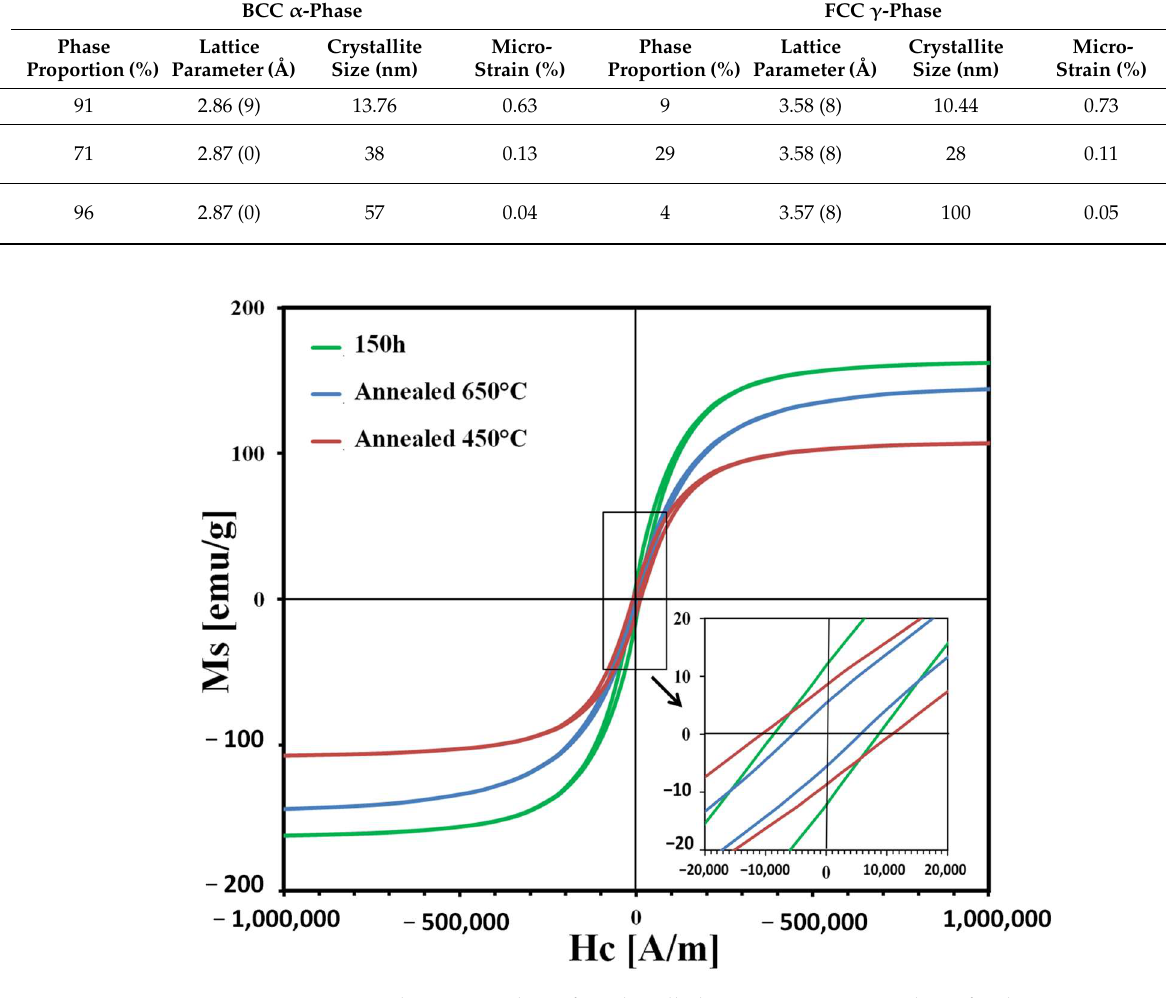
Figure 10. Magnetic hysteresis plots of 150 h milled Fe 70 Ni 12 B 16 Si 2 powders after heat